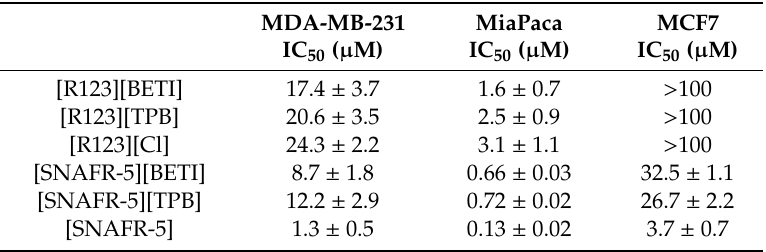
Table 2. IC 50 values for R123- and SNAFR-5-based nanoGUMBOS towards MDA-MB-231, MiaPaca, and MCF7 cancer cell